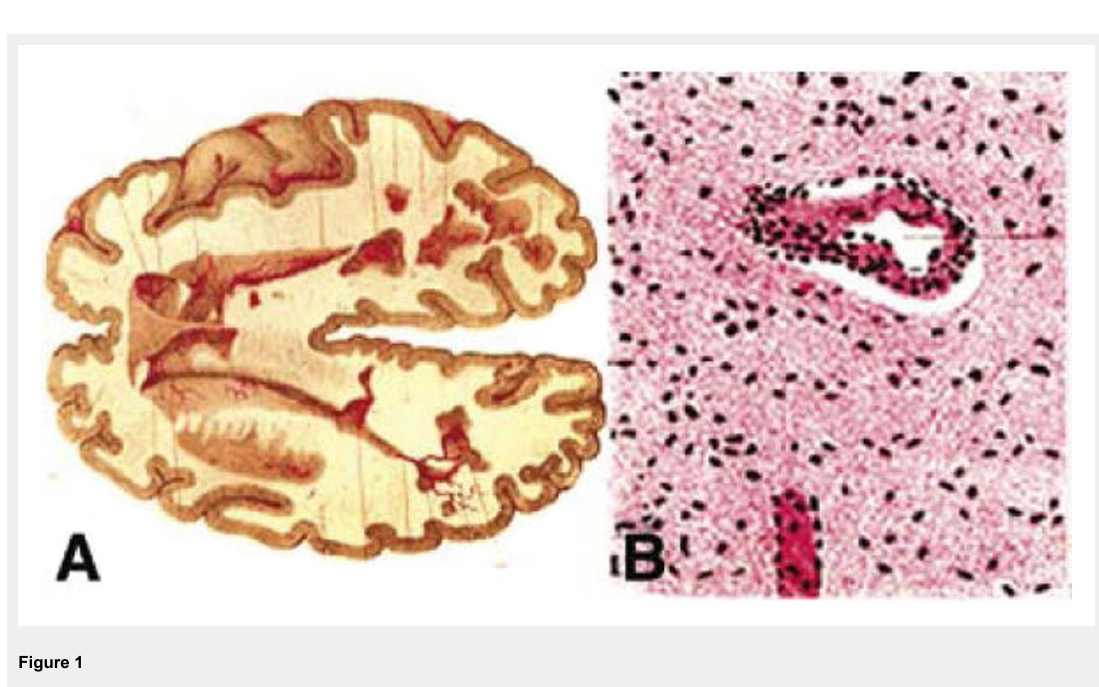
The multiple sclerosis plaque, classical portrayals. A. Plaques embedded in brain white matter (Charcot 1880); B. perivascular and parenchymal inflammatory infiltrates (Babinski, 1885). (from H. Lassmann, Brain Pathol.